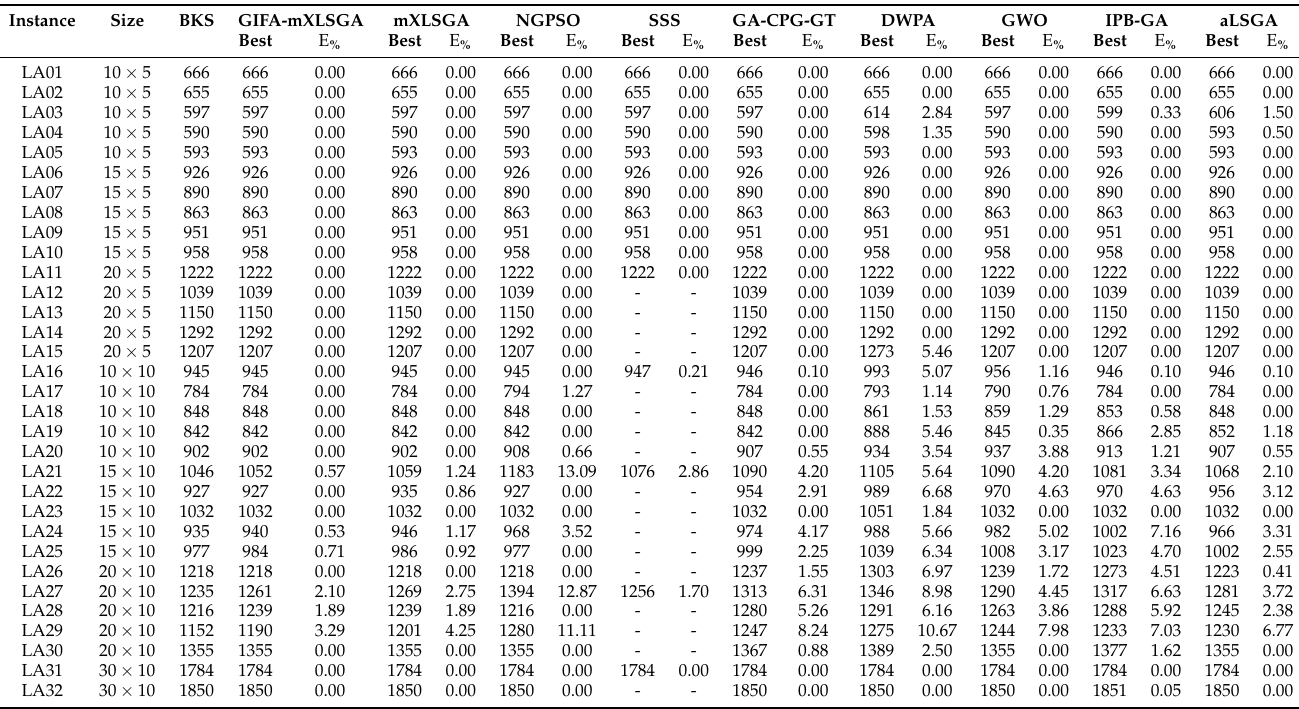
Table 3. Comparison of computational results between GIFA-mXLSGA and other algorithms for LA. The symbol “-” means “not evaluated in that instance”. Best Best Best Best E